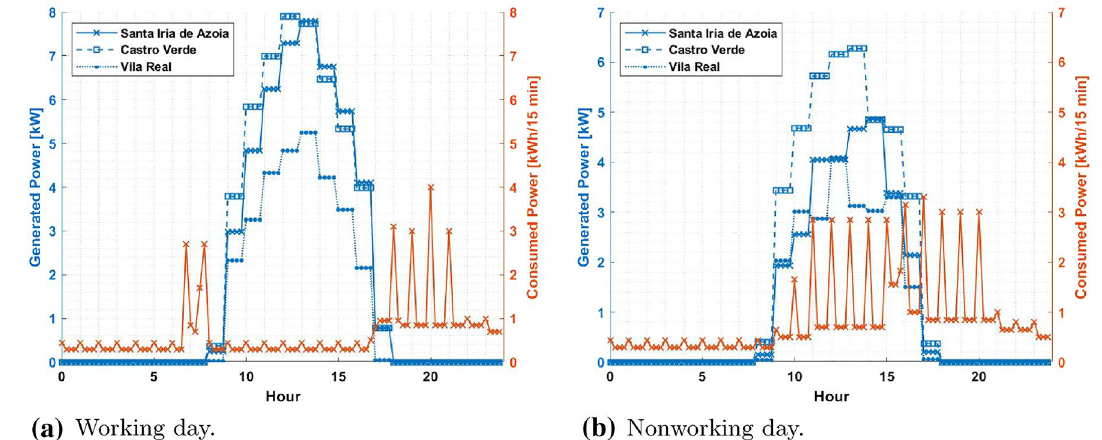
Fig. 13 Generation and consumption curves on the two significant days of January for CIGS technology